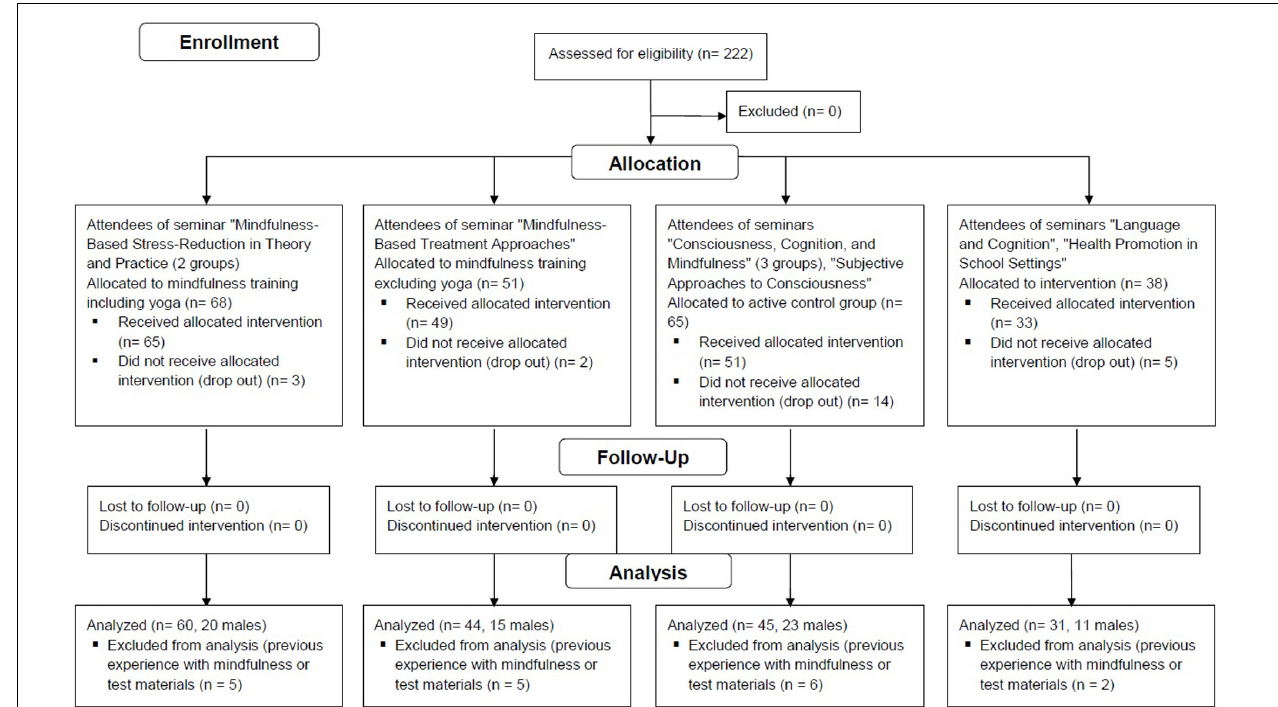
FIGURE 1 | Flow of participants through the